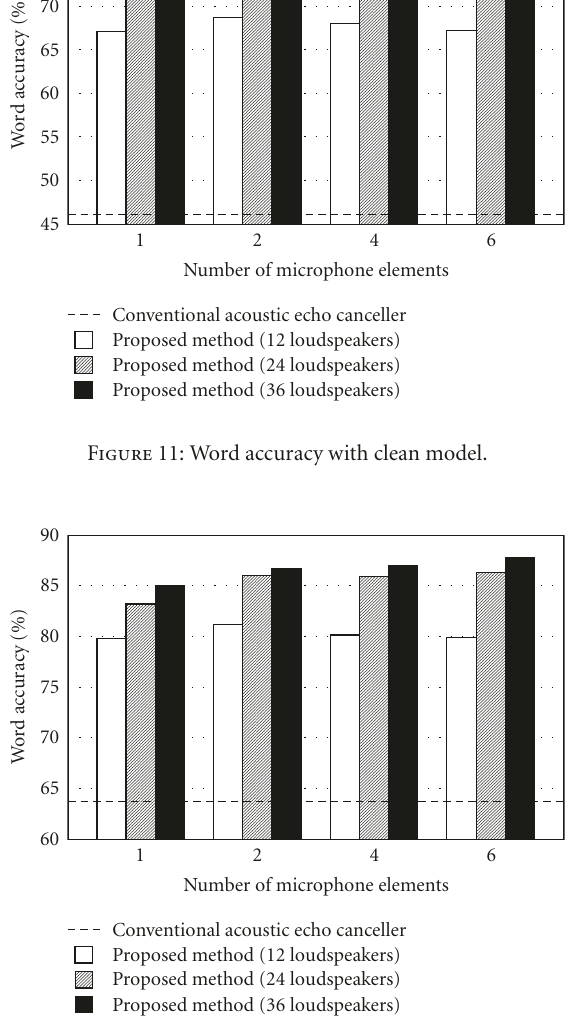
Figure 12: Word accuracy when known-noise imposition tech- nique is applied.